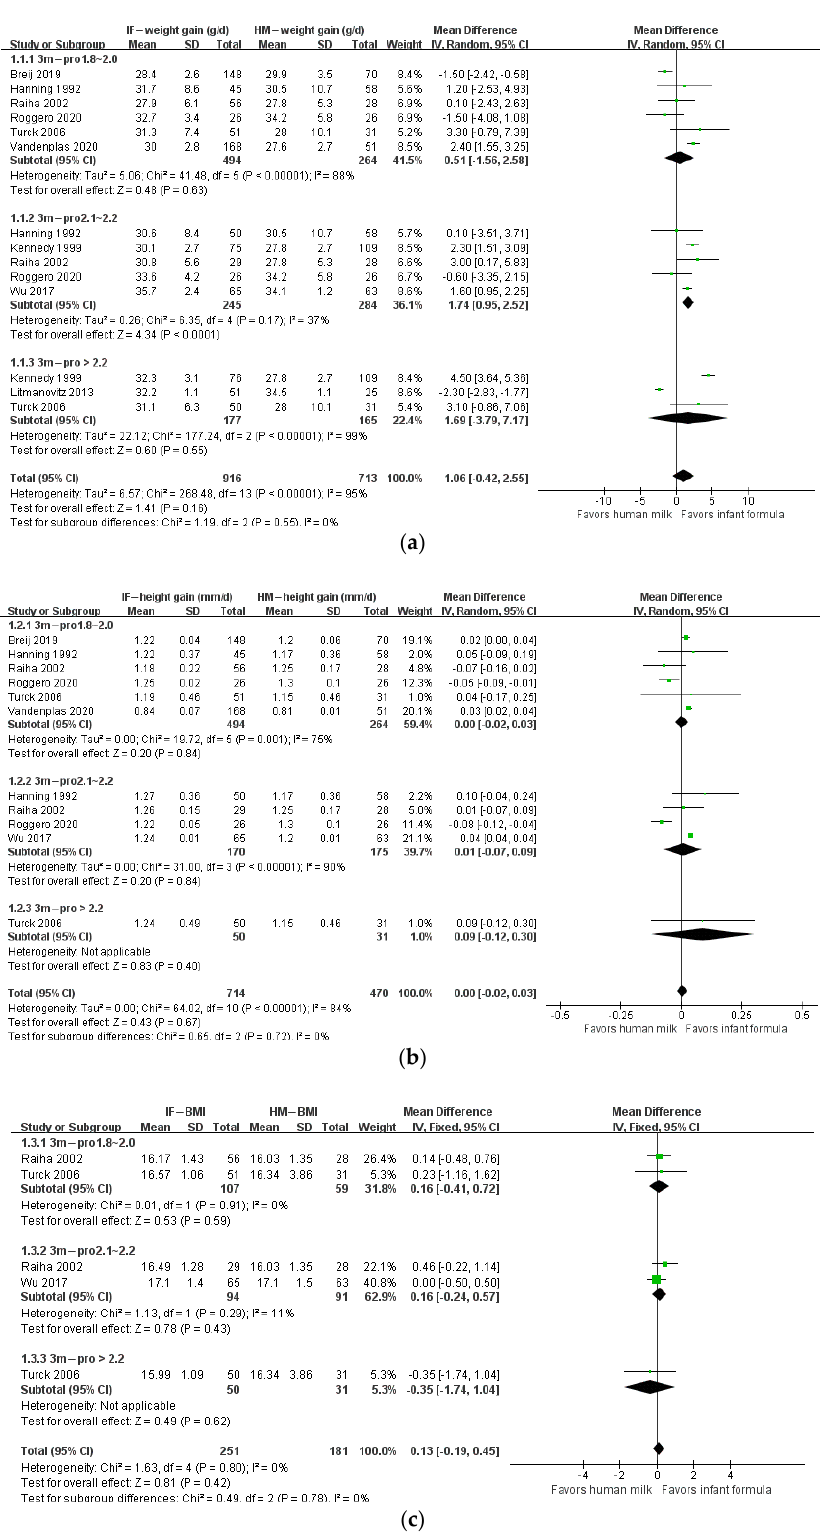
Figure 3. Forest plot of the effects of protein content of infant formula on the weight gain, height gain, and BMI of infants at 2 months of age. ( a ) The effects on weight gain. ( b ) The effects on height gain. ( c ) The effects on BMI.